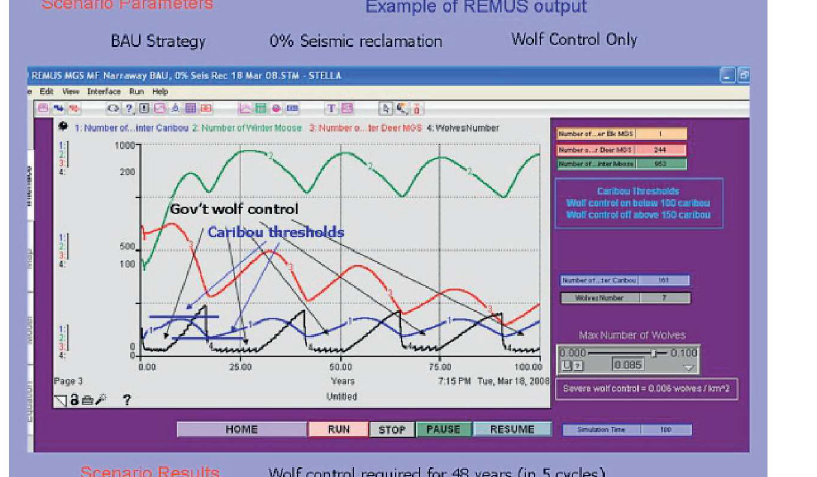
Fig. 5. Example of a REMUS computer model output for the Narraway woodland caribou herd in west central Alberta based on a 100 year scenario of business as usual for the oil and gas industry, no reclamation of seismic lines, wolf control initiated when the Narraway herd declines below 100 animals and wolves are controlled at 6/1000 km 2 until the caribou herd increases to 150 animals. Moose and deer are available for sport hunting, but aren't controlled.